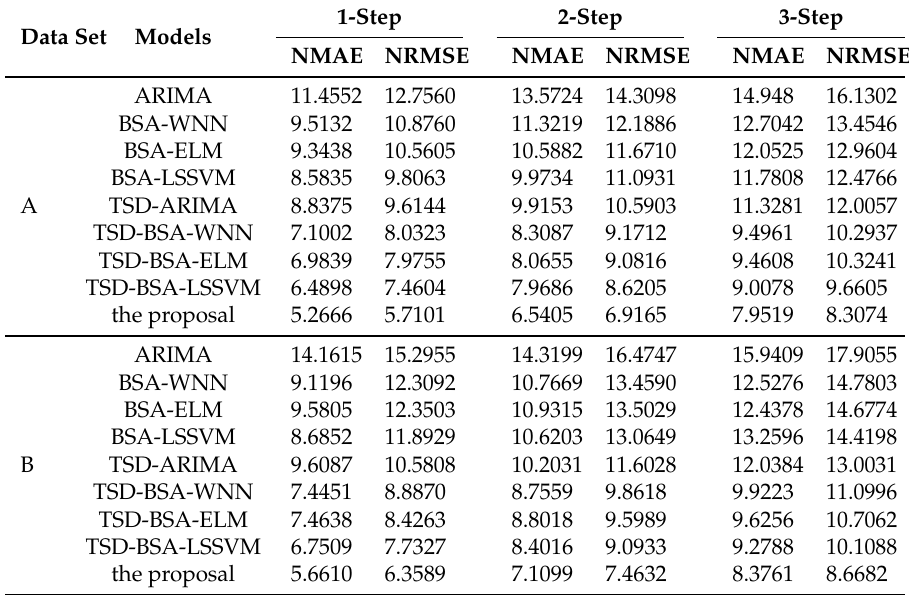
Table 3. Forecasting results obtained by different individual models (%).